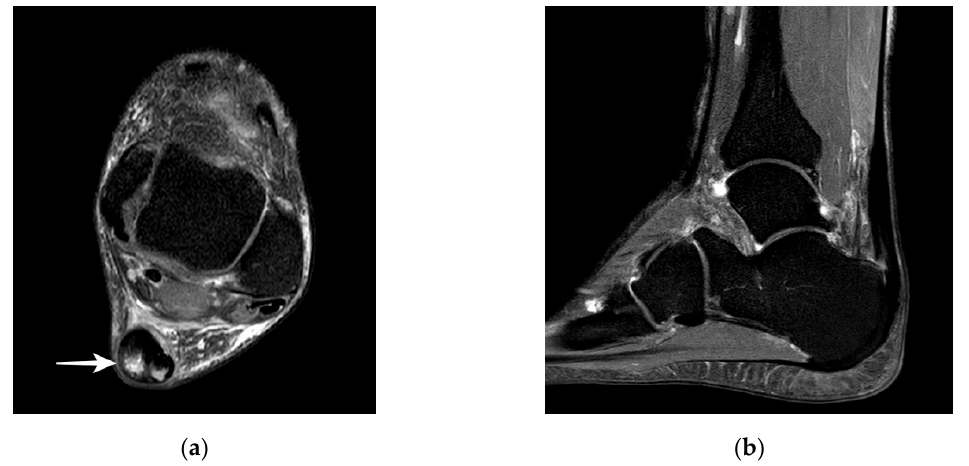
Figure 3. MR images of partial Achilles tendon ruptures: ( a ) partial rupture in the dorsal part of the midportion; ( b ) partial rupture in the insertion. MR; magnetic resonance.